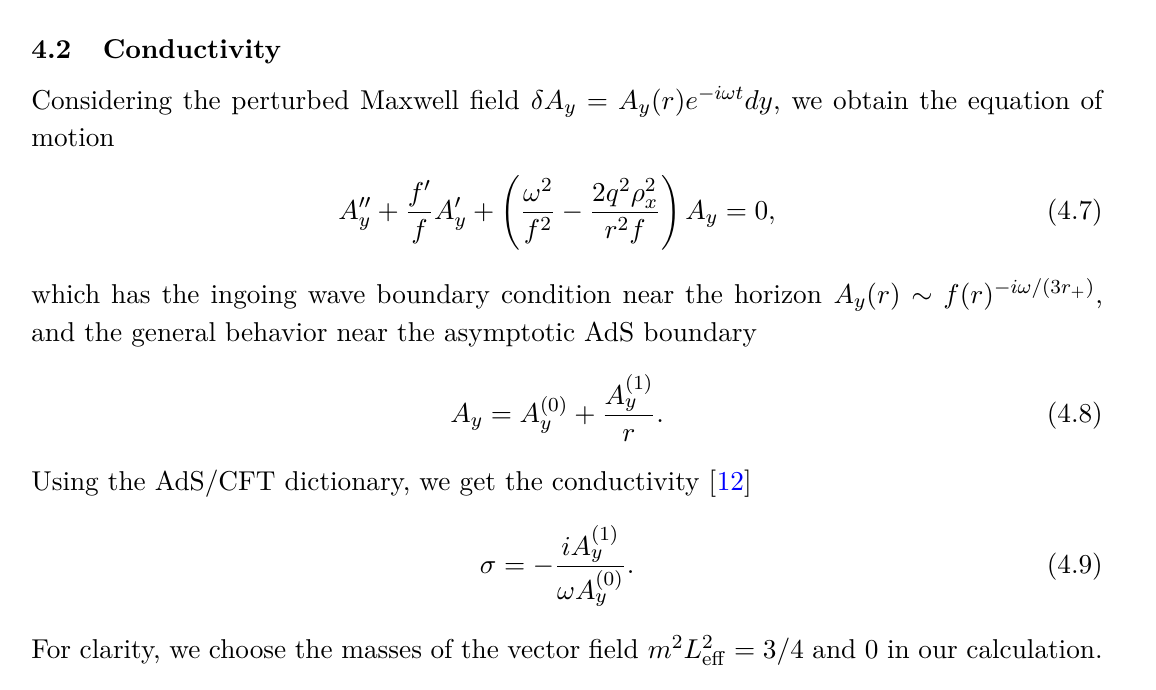
Figure 7 . The critical temperature T c of the vector operator O x as a function of the Gauss- Bonnet parameter for the fixed masses of the vector field by choosing values of m 2 L 2 (left) and m 2 L 2 eff